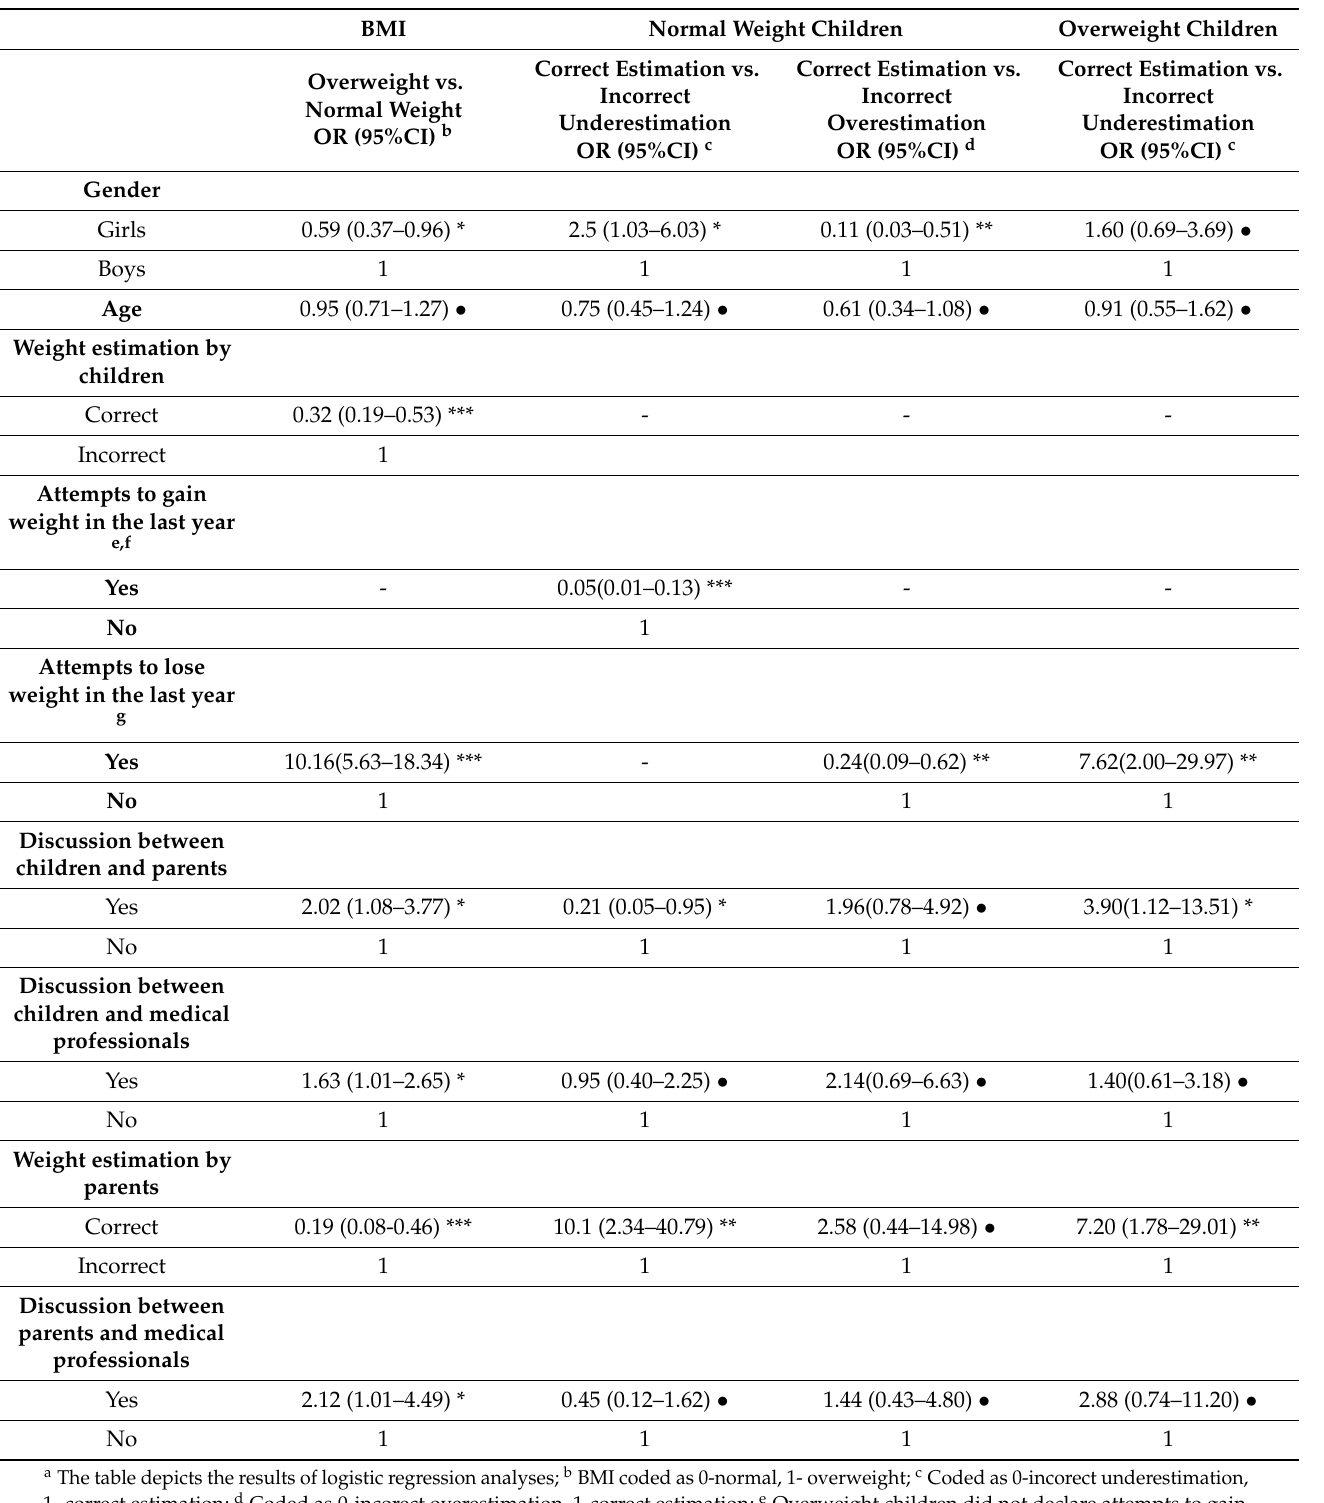
Table 2. Factors associated with BMI, correct, underestimation and overestimation of their own weight among Romanian children